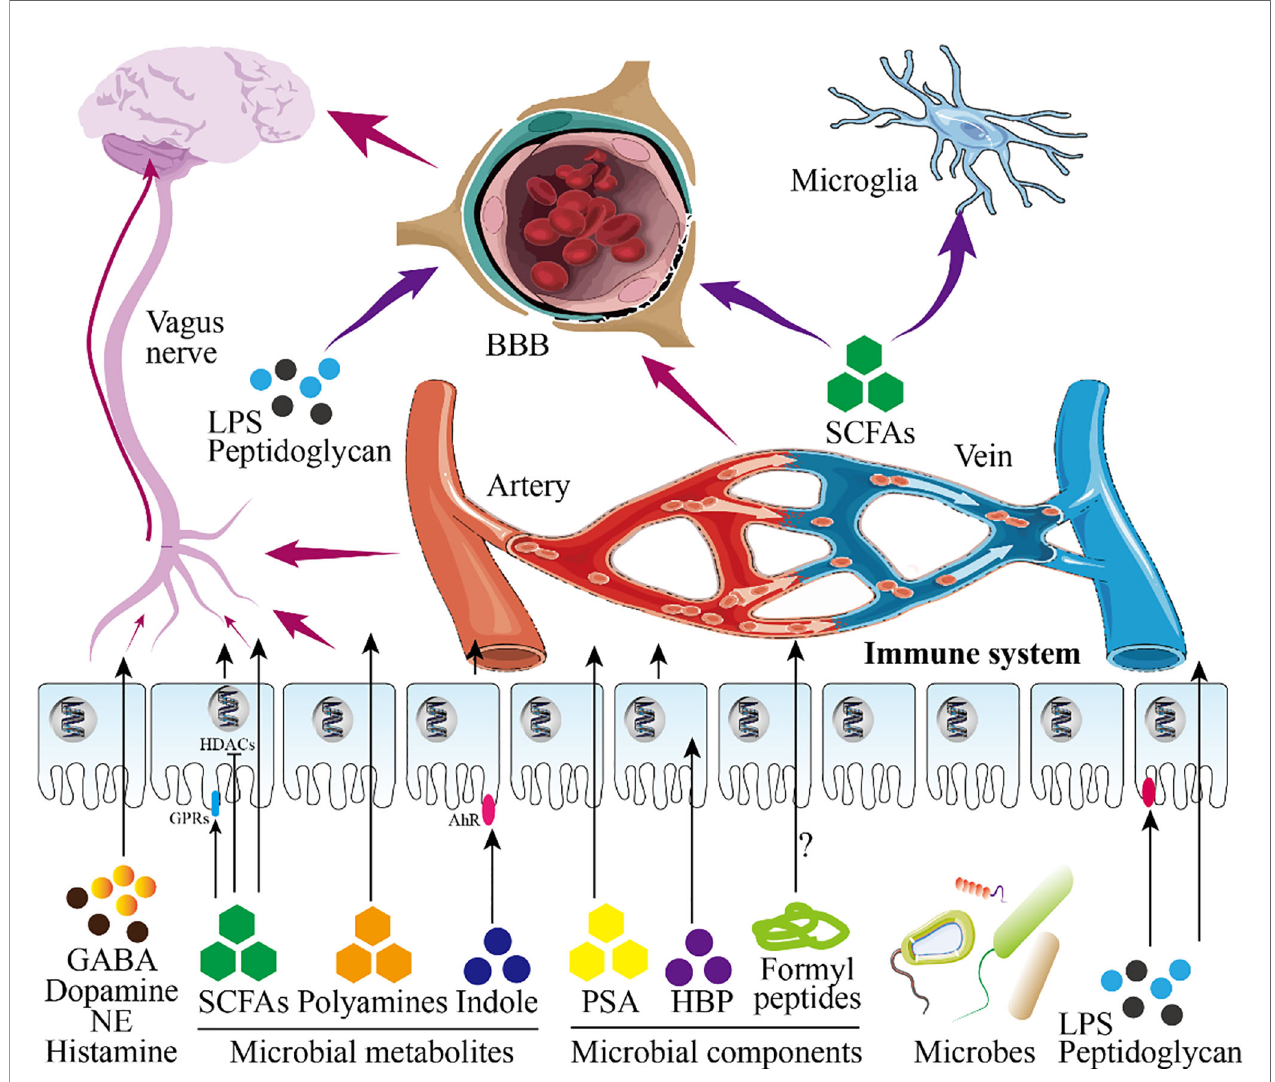
FIGURE 3 | Infant gut microbiota and central nervous system. This fi gure shows the role of infant microbiota in the central nervous system (CNS). Microbial metabolites and microbial components directly pass-through epithelial cells or act on receptors on epithelial cells to play a role (in this fi gure, intestinal epithelial cells are taken as an example). On the one hand, these substances will further reach the blood-brain barrier (BBB) after entering the blood circulation and enter the brain to participate in the regulation of the CNS after passing through the BBB. On the other hand, these substances continue to undergo biochemical reactions in the blood circulation to affect the CNS. Besides, SCFAs and LPS entering the blood circulation can also directly act on nerve cells. Shortly, these substances regulate the development of the brain and